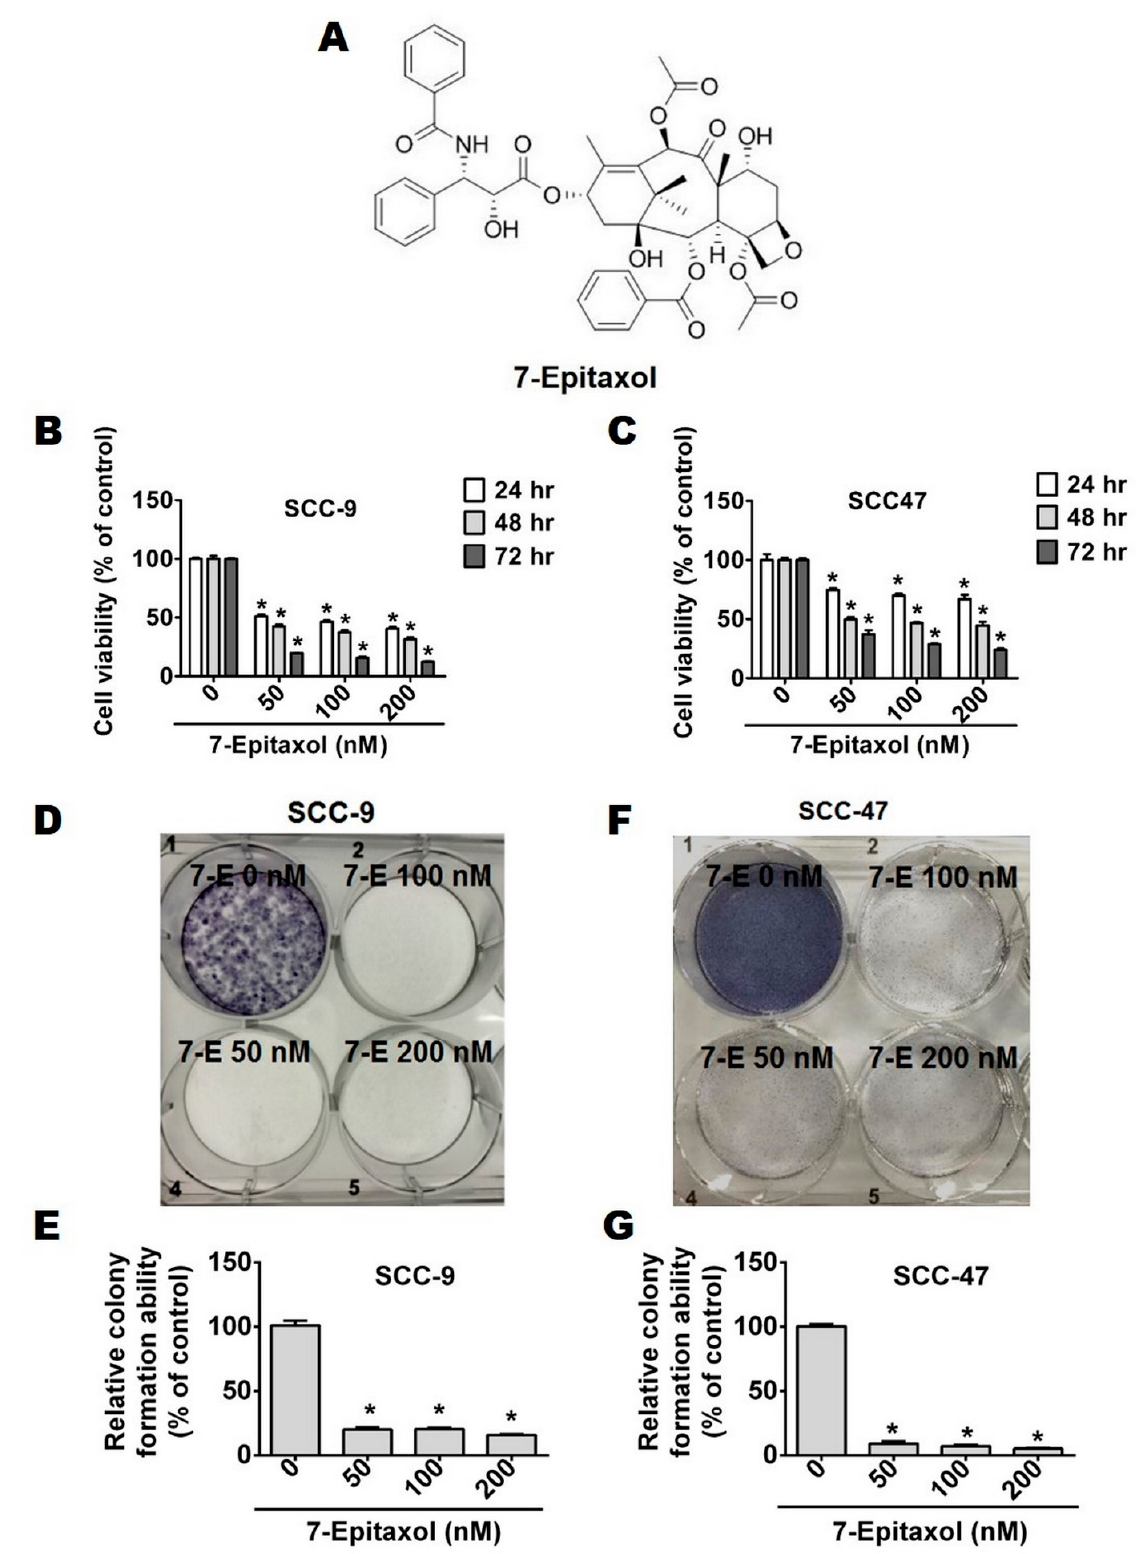
Figure 1. The cytotoxicity effects of 7-Epitaxol in SCC-9 and SCC-47 cell lines. ( A ) The chemical structure of 7-E. Cell viability was measured by MTT assay. ( B ) SCC-9 and ( C ) SCC-47 cells were treated with the indicated concentration of 7-E (0, 50, 100 and 200 nM) for 24, 48 and 72 h. ( D , E ) SCC-9 and ( F , G ) SCC-47 were analyzed by colony formation assay and cells were cultured in the condition medium presence of 7-E (0–200 nM) for 14 days. Data are presented as mean ± SD ( n = 3). * p < 0.05, compared with the control